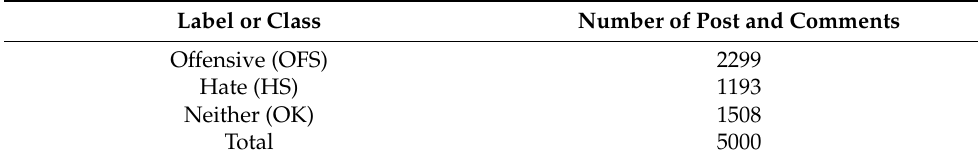
Table 5. The three-class distribution of the